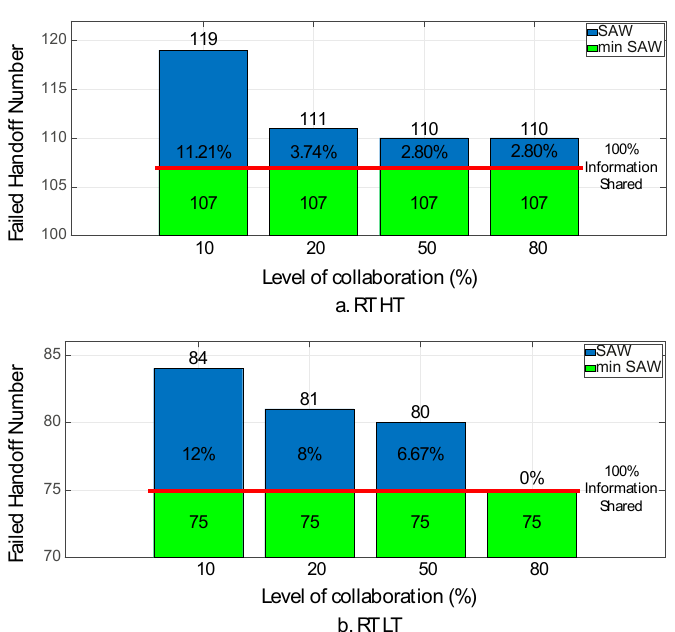
Figure 21. Relation failed handoffs for SAW: ( a ) Real time (RT) and high traffic (HT); ( b ) Real time (RT) and low traffic (LT).